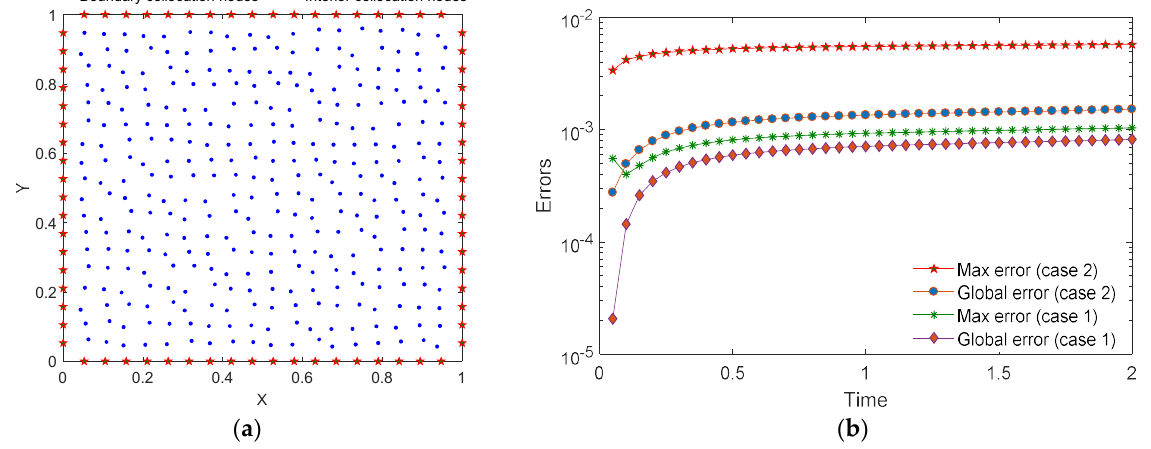
Figure 2. ( a ) Irregular distribution of 396 collocation nodes, ( b ) Global and max errors of hydraulic head H from 0 t to 2 t .